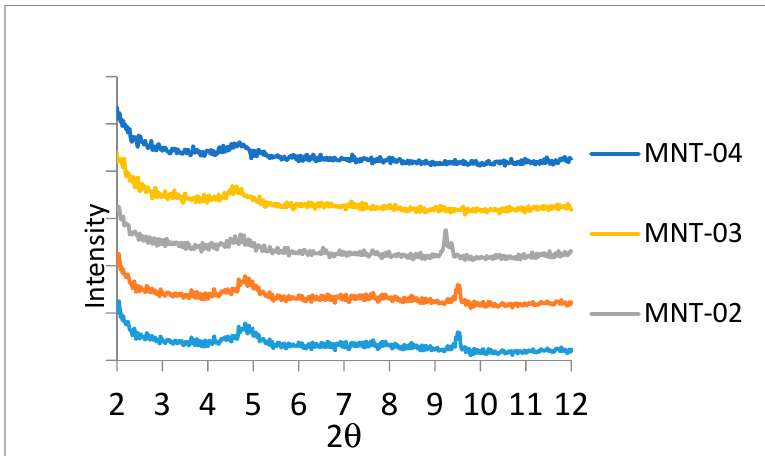
Figure 5. X-ray diffraction characteristic peaks for an MNT-filled PA membrane. The inclusion of MNT into the PA layer was done by the dispersion of a definite amount of nanoclays (0.005 wt.%, 0.01 wt.%, 0.02 wt.%, 0.03 wt.%, and 0.04 wt.%) in TMC-hexane solution. MNT-005, MNT-01, MNT-02, MNT-03, and MNT-04 refer to MNT incorporation of 0.005 wt.%, 0.01 wt.%, 0.02 wt.%, 0.03 wt.%, and 0.05 wt.%, respectively.